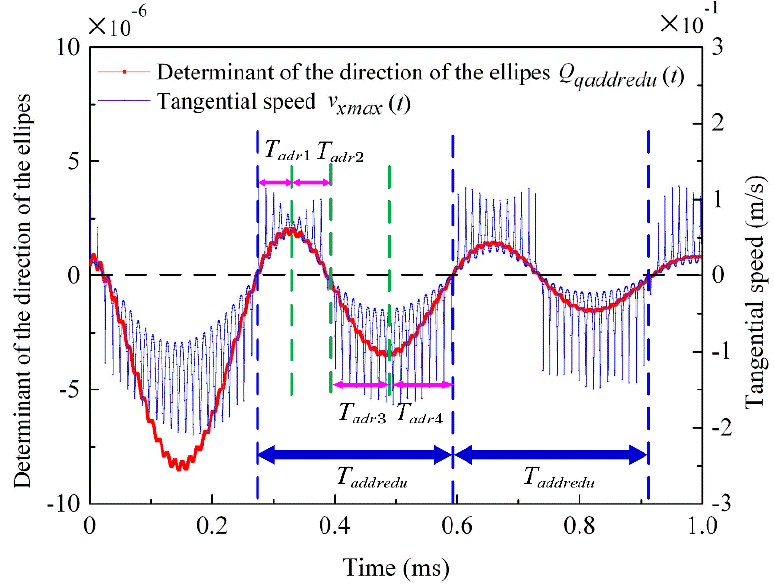
Figure 14. Variation curve determining factor equation for the elliptical motion direction. +.